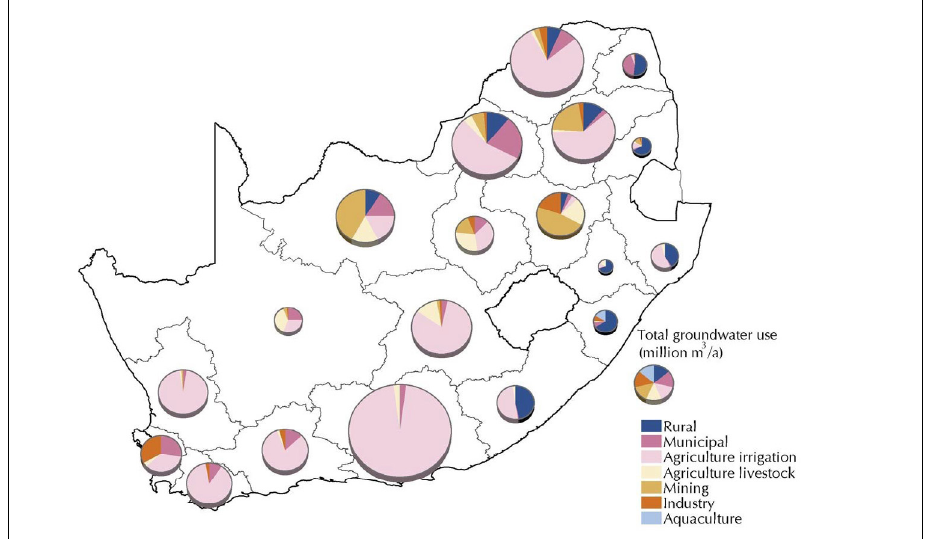
Total groundwater use in South Africa is dominated by the agricultural